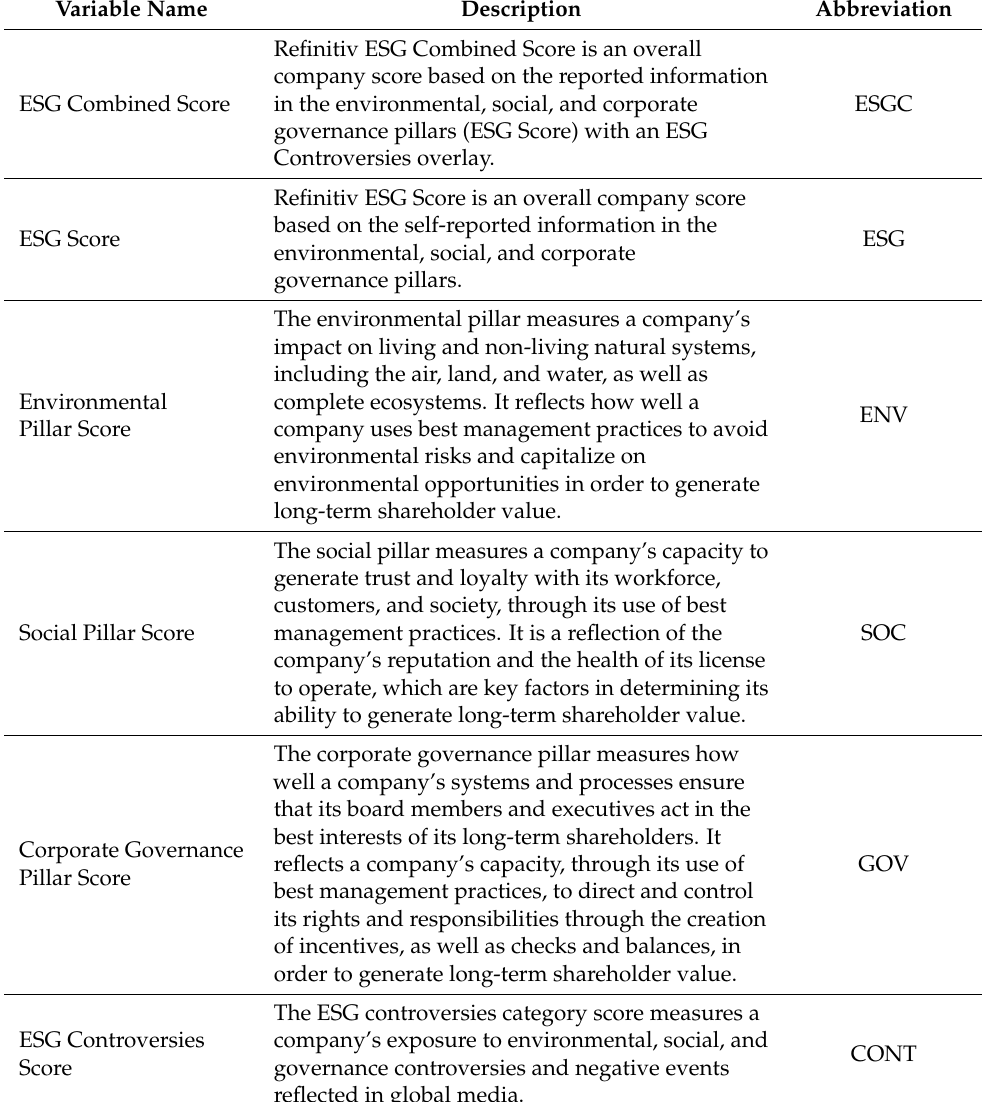
Table 4. Description of ESG